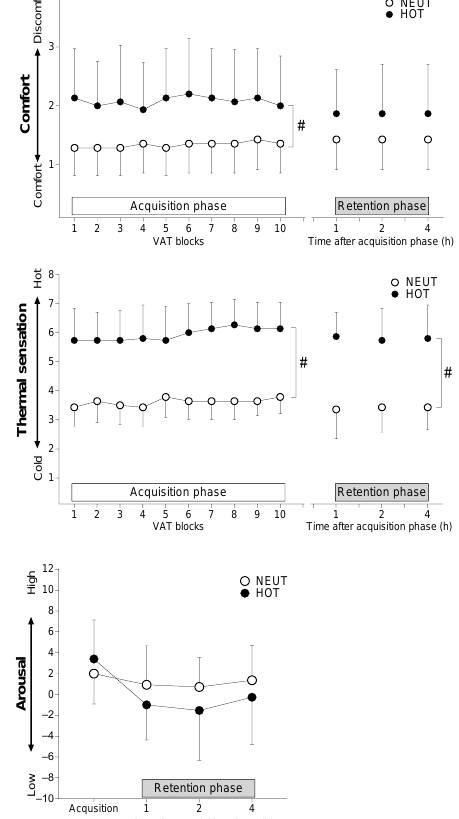
Figure 6. Comfort and thermal sensations during VAT tasks in thermoneutral (NEUT) and hot (HOT) environments for acquisition (left panel) and retention (right panel) phases. Values are presented as means ± SD. n = 14 and 15 for NEUT and HOT conditions, respectively. #, the main effect of environment (all p ≤ 0.005).